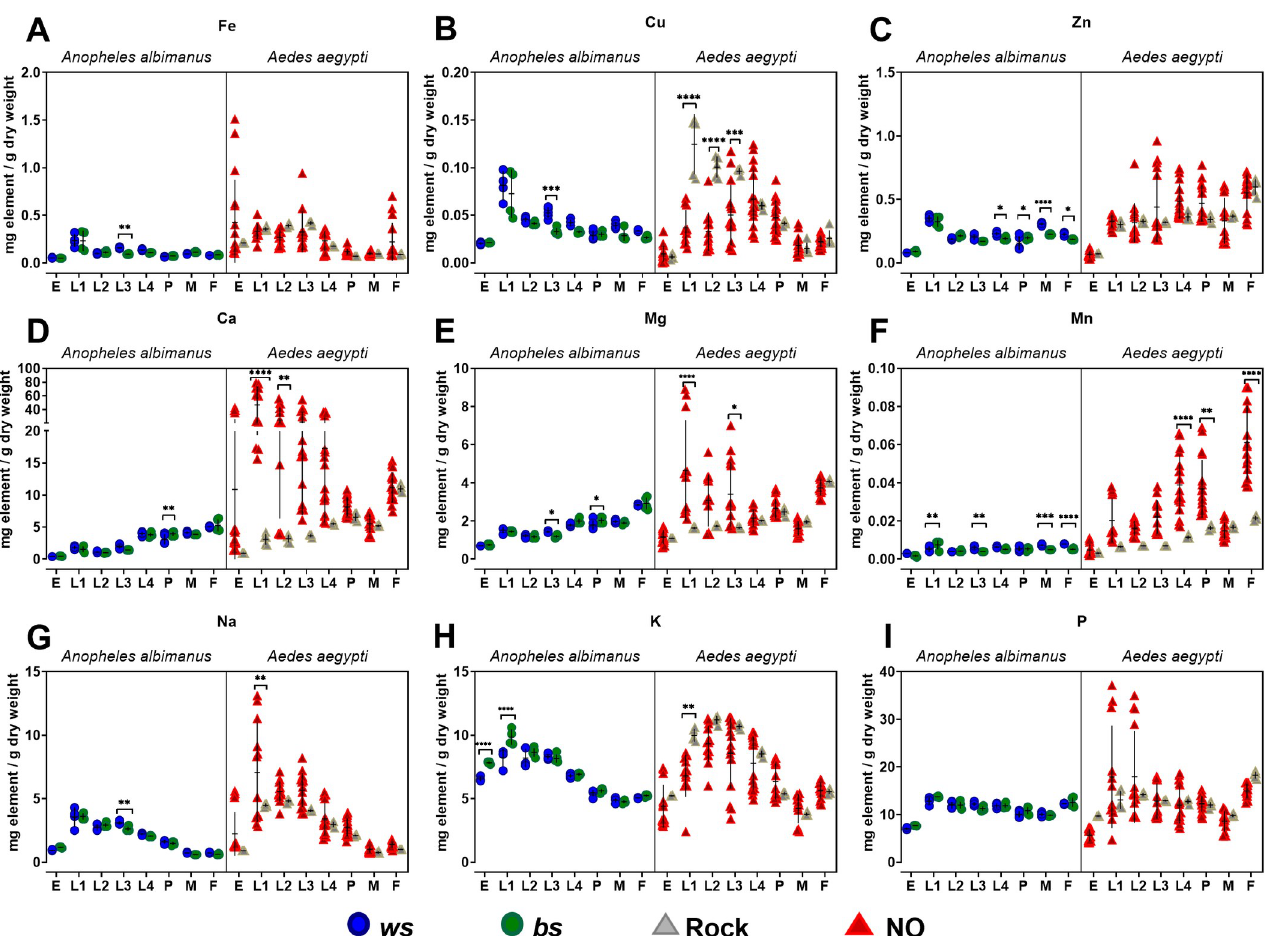
Fig 2. Metallomics during the life cycle of An . albimanus and Ae . aegypti . Metal concentrations were determined by ICP-OES in ws (blue circles) and bs (green circles) phenotypes from An . albimanus , Rock (grey triangles) and NO (red triangles) strains from Ae . aegypti , and throughout their life cycle. Panels show different metal ions measured simultaneously in the same samples. A) Iron. B) Copper. C) Zinc. D) Calcium. E) Magnesium. F) Manganese. G) Sodium. H) Potassium. I) Phosphorus. Letters on the X-axis represent instar/stage as follows: E = eggs, L1-L4 = instar 1–4 larvae, P = Pupae, M = Adult male, F = Adult female. Data are expressed as mean ± standard deviation (SD) from several independent measurements taken from two to four biological replicates. Data were tested for normality by the Shapiro-Wilk test and statistical analisys was performed by two-way ANOVA followed by post-hoc Bonferroni-corrected test comparing the ws to bs phenotypes and the Rock to NO strains at each stage. For further comparisons see S1 Table.